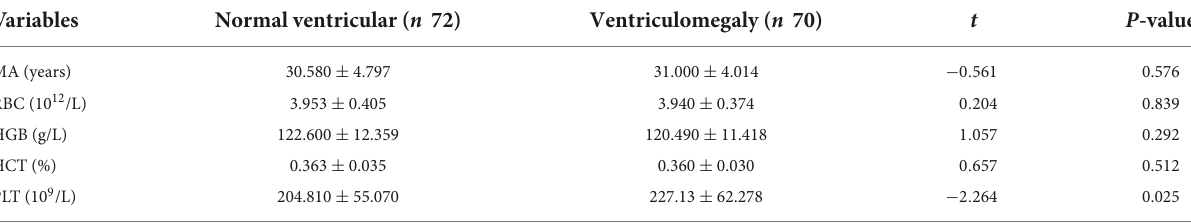
TABLE 1 Demographic features and maternal blood parameters in different groups.